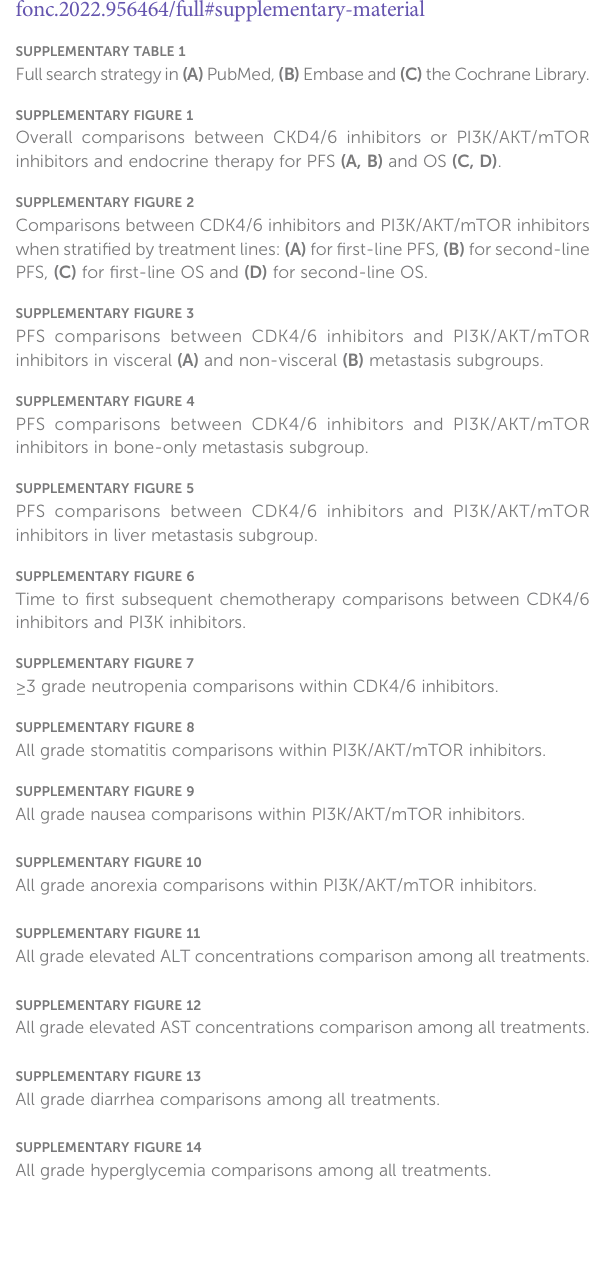
SUPPLEMENTARY FIGURE 1 Overall comparisons between CKD4/6 inhibitors or PI3K/AKT/mTOR inhibitors and endocrine therapy for PFS (A, B) and OS (C, D) . SUPPLEMENTARY FIGURE 2 Comparisons between CDK4/6 inhibitors and PI3K/AKT/mTOR inhibitors when strati fi ed by treatment lines: (A) for fi rst-line PFS, (B) for second-line PFS, (C) for fi rst-line OS and (D) for second-line OS. SUPPLEMENTARY FIGURE 3 PFS comparisons between CDK4/6 inhibitors and PI3K/AKT/mTOR inhibitors in visceral (A) and non-visceral (B) metastasis subgroups. SUPPLEMENTARY FIGURE 4 PFS comparisons between CDK4/6 inhibitors and PI3K/AKT/mTOR inhibitors in bone-only metastasis subgroup. SUPPLEMENTARY FIGURE 5 PFS comparisons between CDK4/6 inhibitors and PI3K/AKT/mTOR inhibitors in liver metastasis subgroup. SUPPLEMENTARY FIGURE 6 Time to fi rst subsequent chemotherapy comparisons between CDK4/6 inhibitors and PI3K inhibitors. SUPPLEMENTARY FIGURE 7 ≥ 3 grade neutropenia comparisons within CDK4/6 inhibitors. SUPPLEMENTARY FIGURE 8 All grade stomatitis comparisons within PI3K/AKT/mTOR inhibitors. SUPPLEMENTARY FIGURE 9 All grade nausea comparisons within PI3K/AKT/mTOR inhibitors. SUPPLEMENTARY FIGURE 10 All grade anorexia comparisons within PI3K/AKT/mTOR inhibitors. SUPPLEMENTARY FIGURE 11 All grade elevated ALT concentrations comparison among all treatments. SUPPLEMENTARY FIGURE 12 All grade elevated AST concentrations comparison among all treatments. SUPPLEMENTARY FIGURE 13 All grade diarrhea comparisons among all treatments. SUPPLEMENTARY FIGURE 14 All grade hyperglycemia comparisons among all